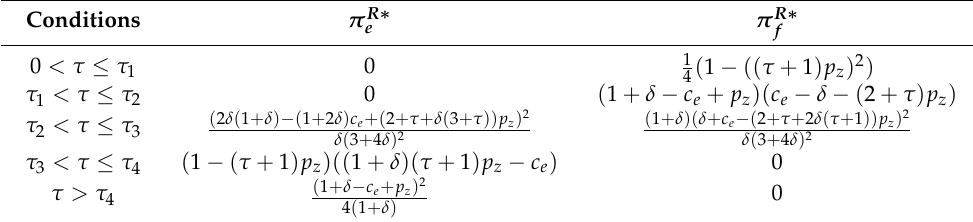
Table 9. Equilibrium profit under the production regulation scenario.